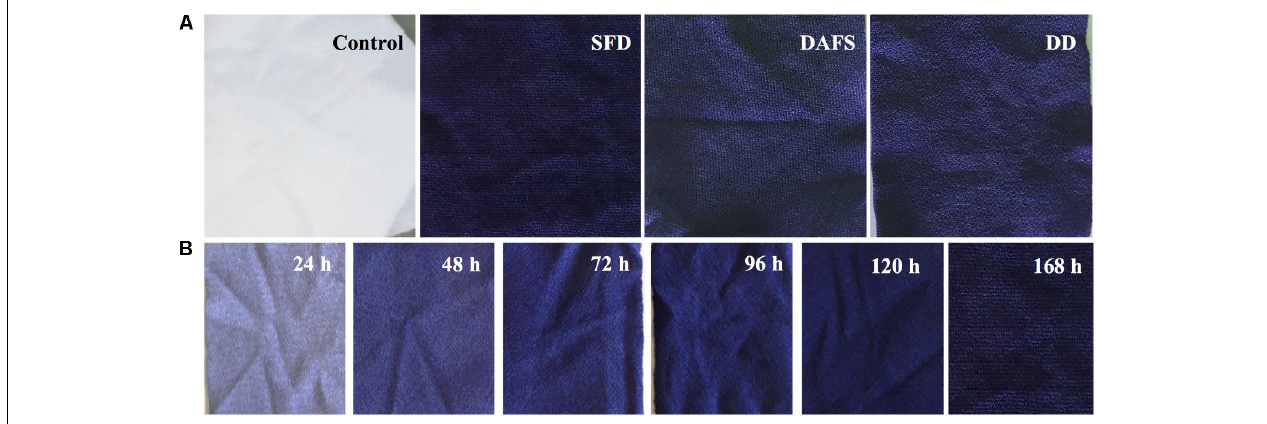
FIGURE 3 | (A) Untreated (control) and dyed fabrics via SFD, DAFS, or DD, (B) different shades, depending on incubation time, of purple-dyed polyamide 6.6 fabrics via SFD.